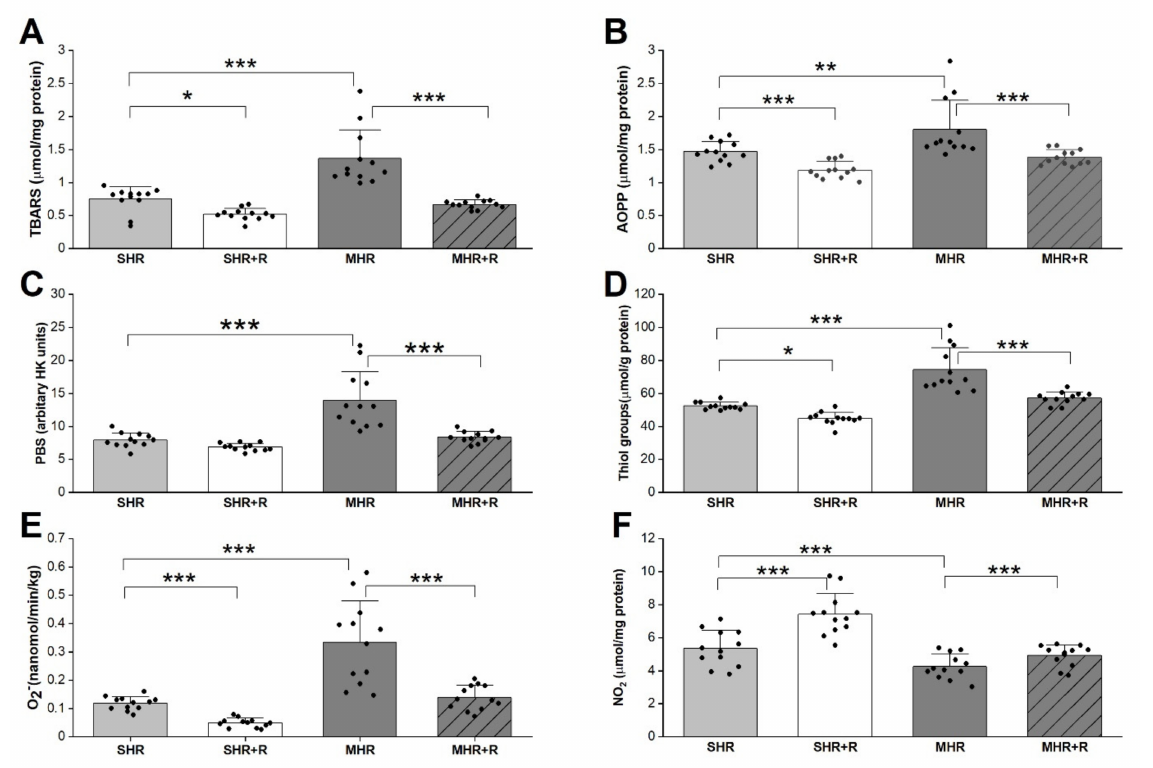
Figure 2. TBARSs-thiobarbituric acid reactive substances ( A ), AOPP-advanced oxidation protein products ( B ), PAB- prooxidative balans ( C ), Thiol groups ( D ), O 2 − -superoxide anion radical ( E ), NO 2 − -nitrites (F) in experimental groups. SHR-spontaneously hypertensive rat; SHR + R-spontaneously hypertensive treated with resveratrol; MHR-malignant hypertensive rat; MHR + R-malignant hypertensive rat treated with resveratrol. Values are means ± SD. ***, **, * indicate p < 0.001, 0.01,